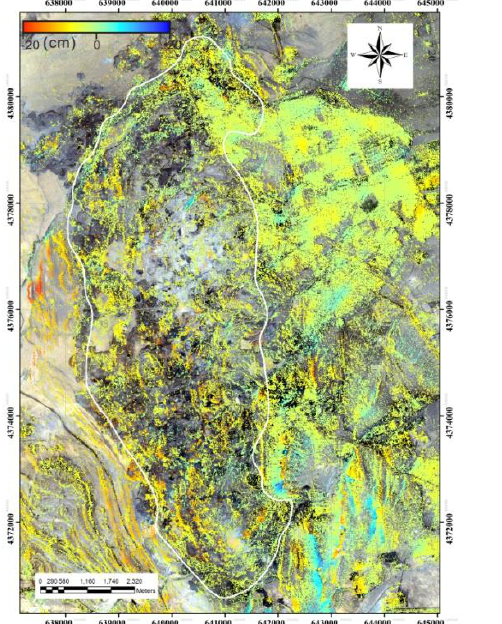
Figure 5. Example of the DEM error correction (here applied to the interferogram covering 18 October 2006 to 18 January 2007). ( a ) The sensitivity to topography was apparent for the original interferogram because of B ⊥ being large, about 1812 m. The spatial unwrapping of the interferogram is unsuccessful due to inaccurate compensation of the topographic phase, which results in wrong deformation pattern. ( b ) DEM correction was estimated and subtracted from the original interferogram. Based on these, it is then typically possible to unwrap this interferogram with longer baselines. The residual topographic noise is significantly reduced on the deformation map after DEM error